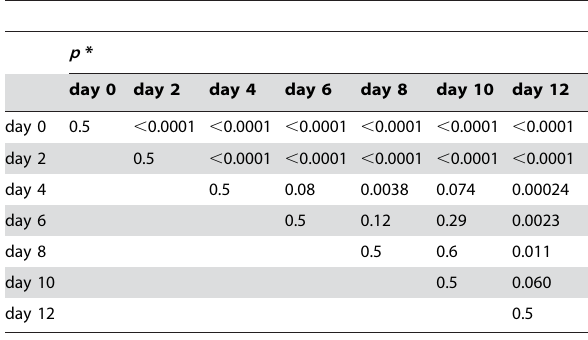
Table 1. Statistical significance of predicted age-scores for each image age group.